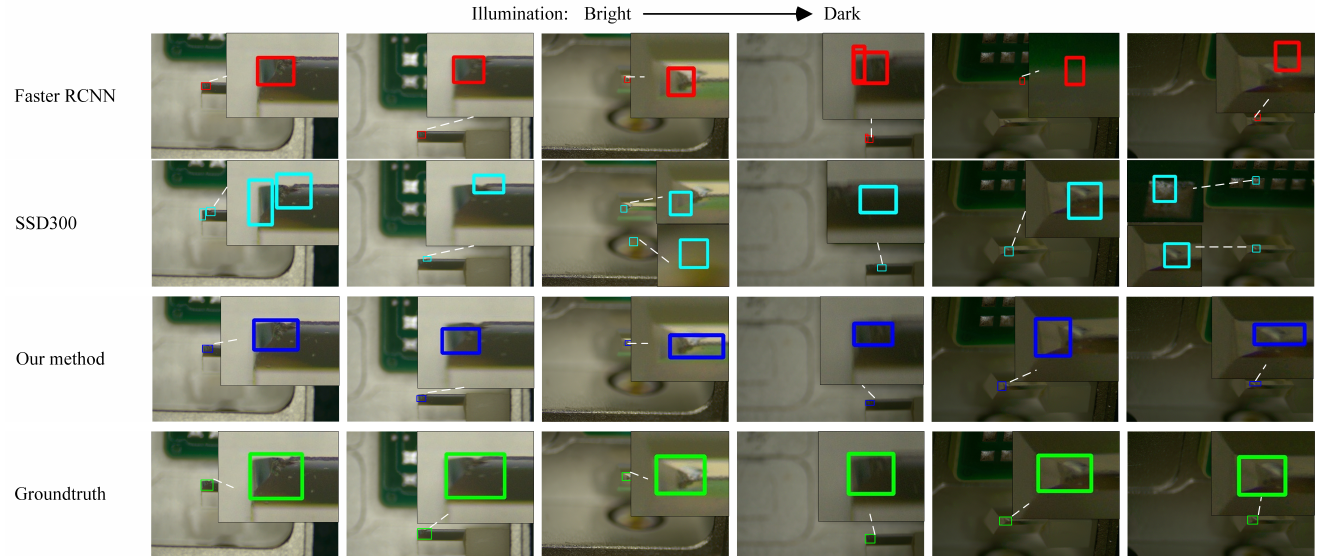
Figure 6. Experiment results under different illumination conditions. The defect area is enlarged and shown in the upper right corner of each image. The first row shows the result of Faster RCNN; the second row shows the result of SSD300 [23]; the third row shows the result of our proposed methods; and the last row shows the ground truth of the testing